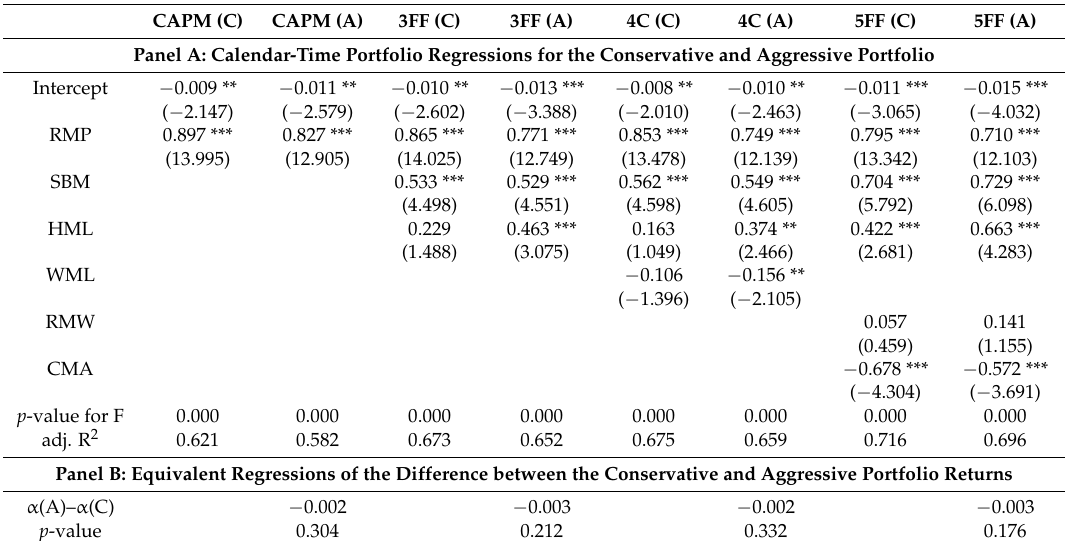
Table 4. Calendar-time portfolio regressions for year in quantiles according to the McNichols model.